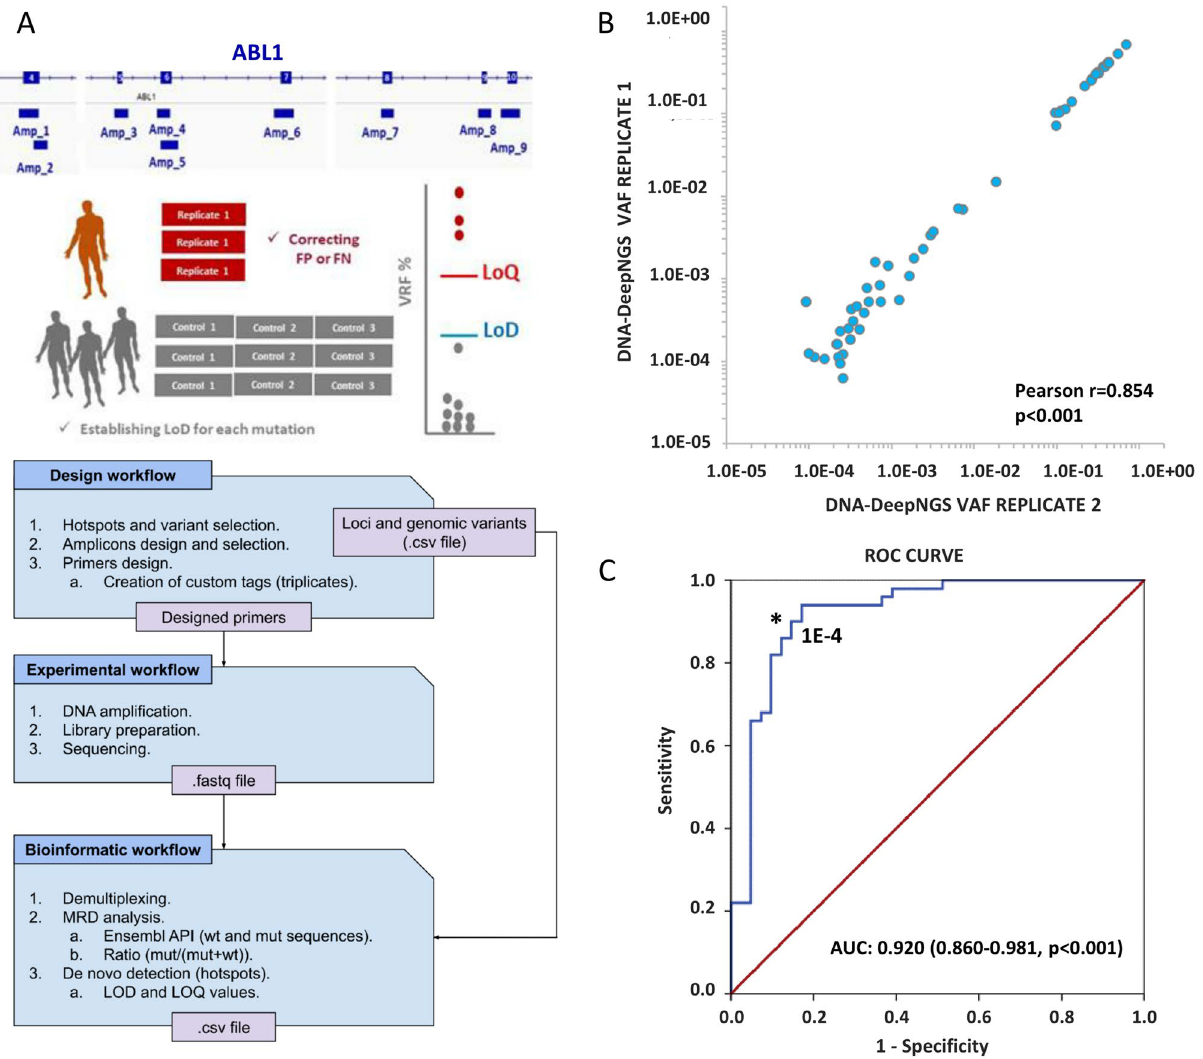
Figure 3. Experimental design and quality metrics resulting for DNA-DeepNGS method. ( A ) Top: nine amplicon-scheme panel designed to cover the entire KD of BCR::ABL1 and the calculation of the intrinsic error; Bottom: bioinformatic pipeline. ( B ) Correlation of two replicates for the DNA-DeepNGS approach ( C ) ROC curve comparing the two methodologies. KD kinase domain, ROC receiver operating